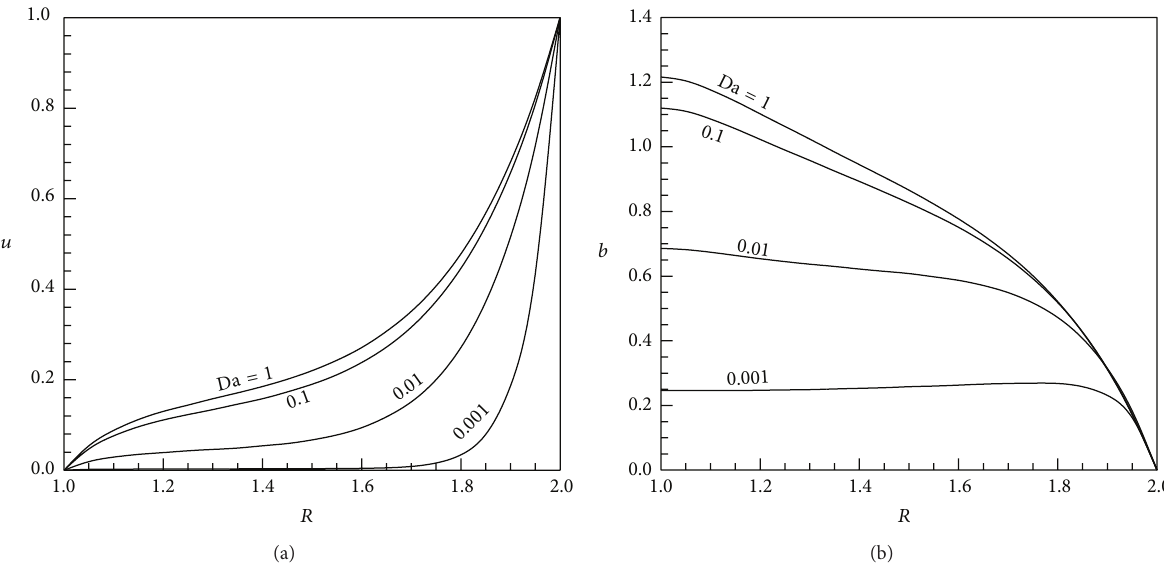
Figure 8: Various profiles for Ha = 10 and different values of Da when the outer cylinder is perfectly insulated while the inner one is perfectly conducting: (a) velocity and (b) induced magnetic